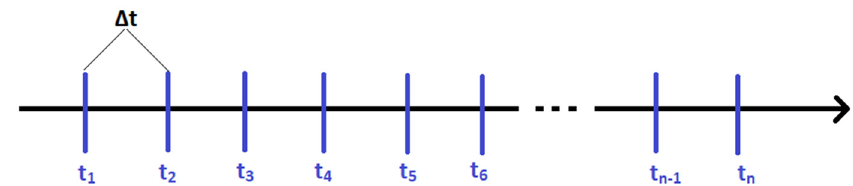
Figure 7. The sample route of the vehicle along with corrections of position from the UWB system or dead reckoning based on the readings (corrections) from the Lidar every Δ t = {1 s or 3 s}.